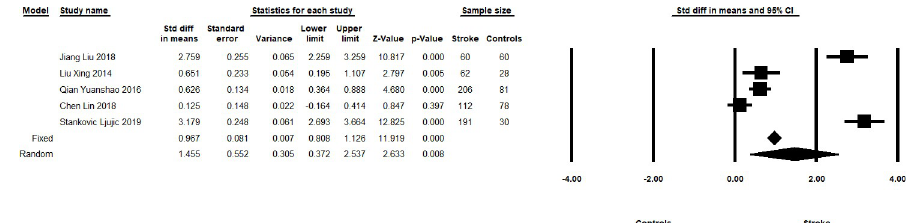
Fig 3. Summary forest plots showing the Meta-SMD and 95% CI of IL-33 levels in stroke patients and healthy controls. The Meta-SMD in the random effects model is shown by the black diamond at the bottom. The vertical line at 0.00 is the border for